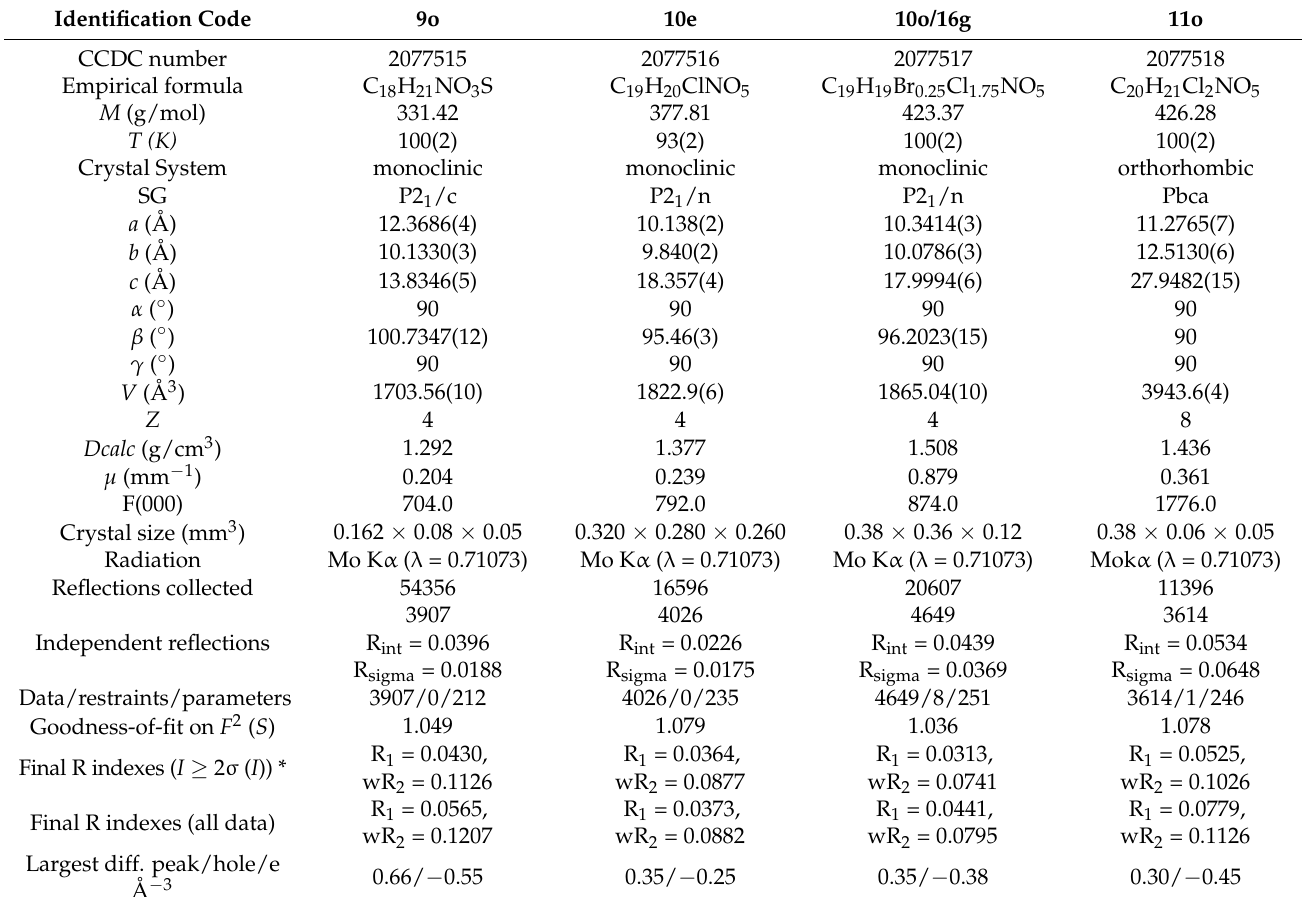
Figure 2. ORTEP representation of the X-ray crystal structure of compound 9o with the thermal ellipsoids set at 50% probability. Table 1. Crystal Data and Structure Refinement Details for compounds 9o , 10e , 10o / 16g and 11o